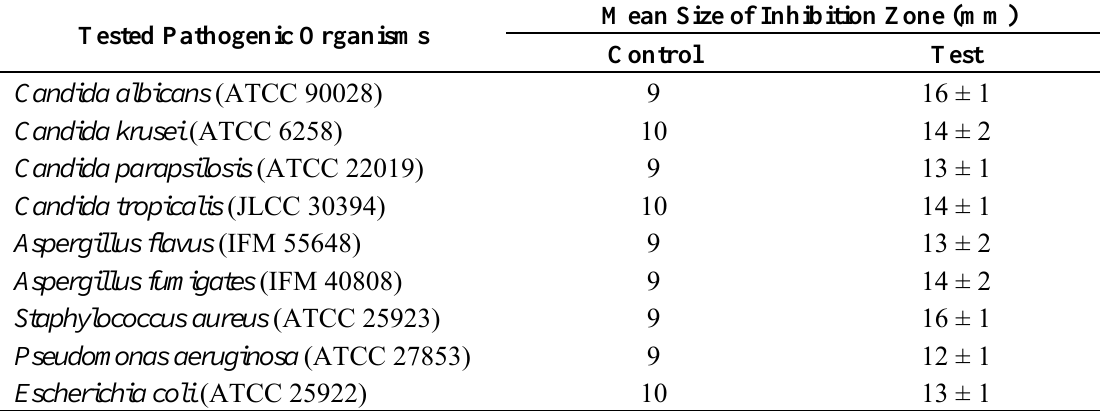
Table 1. Size of the inhibition zone for AgNPs synthesized by Aspergillus terreus against the tested